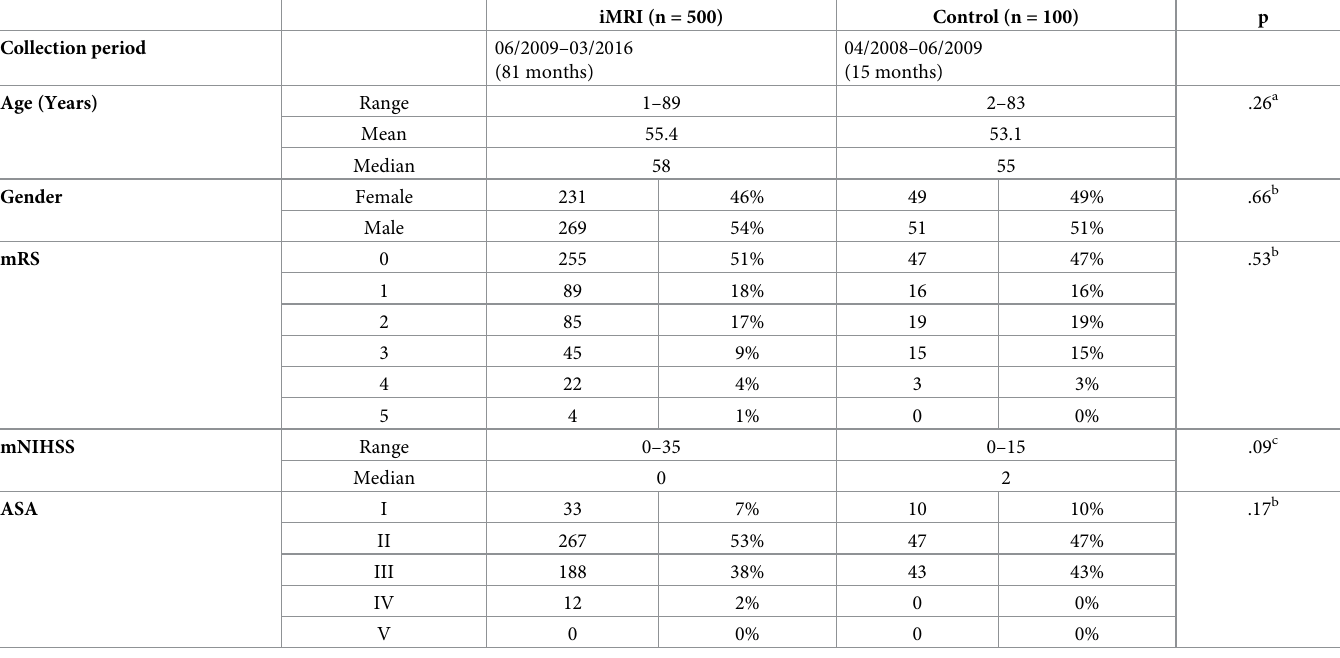
Table 1. Demographics of subjects in both study